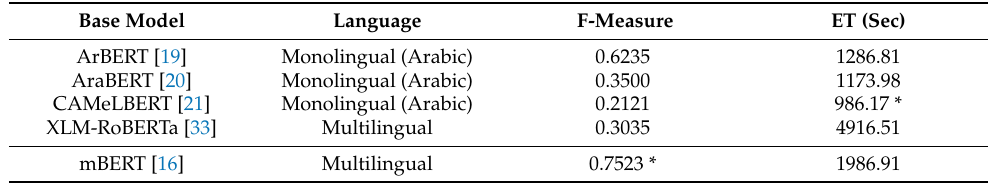
Table 6. Performance comparison of PDTS concerning the closely related state-of-the-art pre-trained base models (the asterisk * indicates the best performance), under the settings ( α = 40 and θ = 0.4). Here, α is set according to the best f-measure score found; see Figure 3.